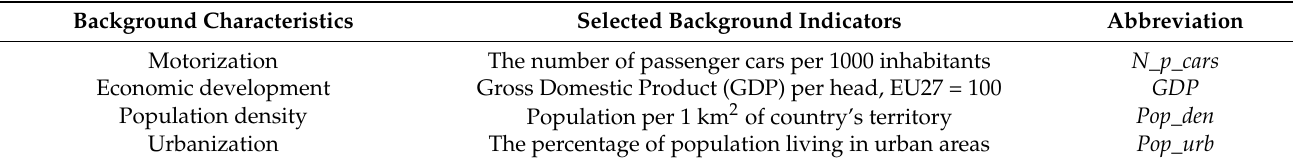
Table 1. Selected background indicators for country